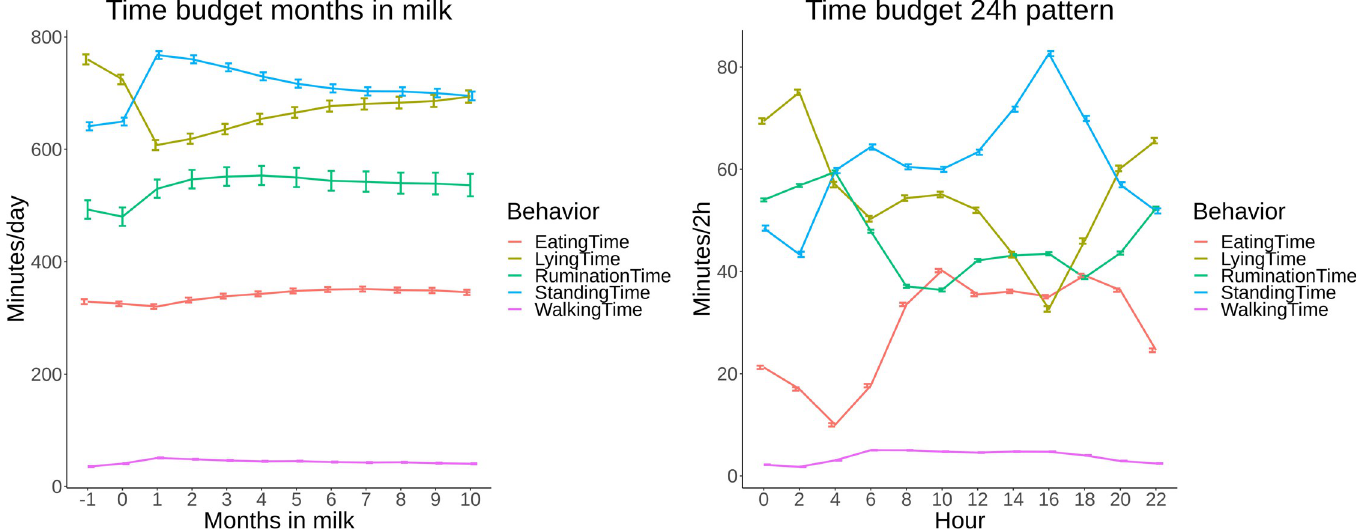
Fig 2. A,B: Overall time budget (eating, rumination, lying, walking and standing) based on least square means (LSM) with 95% confidence intervals (95% CI) of all cows on 8 commercial dairy farms in The Netherlands from 1 month before calving until 10 months in milk with “month 0” consisting of d-1, d0 and d+1 (A) and their overall 24h pattern time budget